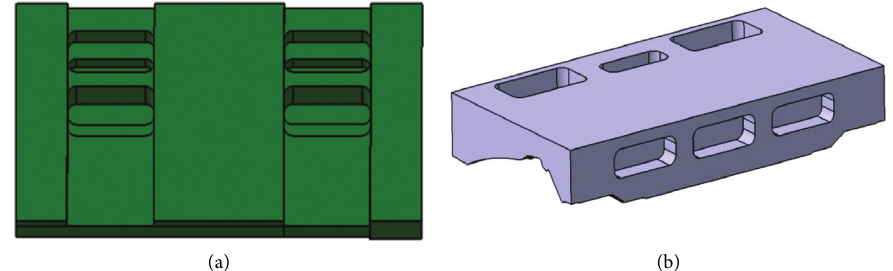
Figure 14: Optimal design of the convex and concave die. (a) Punch optimization design results. (b) Die optimization design